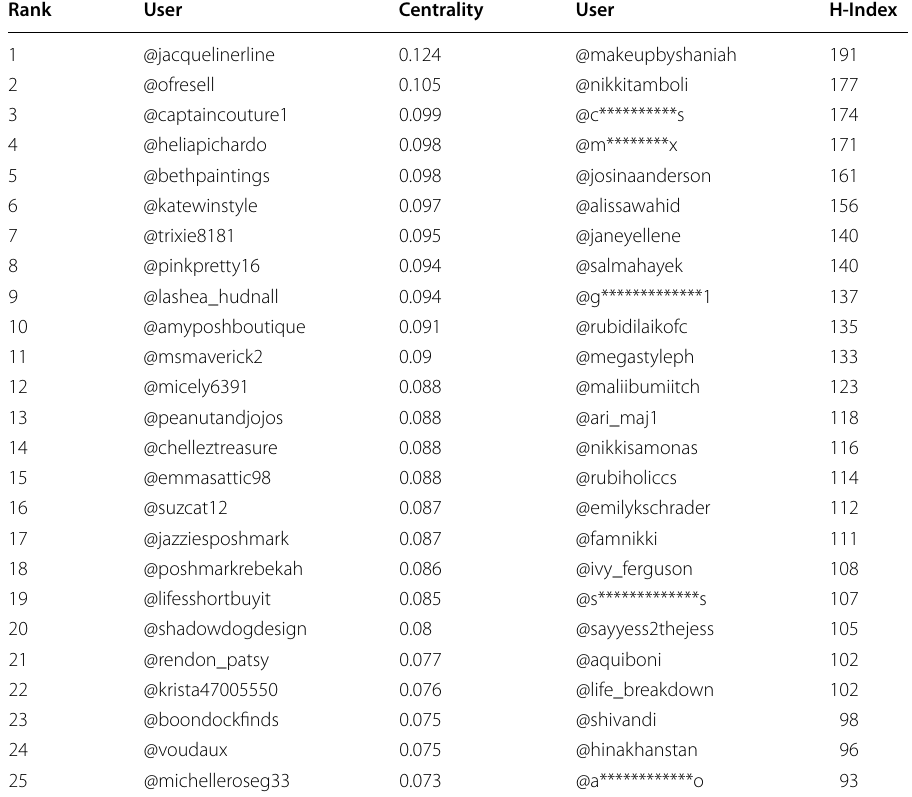
Table 6 Top‑25 influential actors among the young female users interested in fashion sorted by centrality (left side) and h‑index (right side), respectively, in descending order Rank User